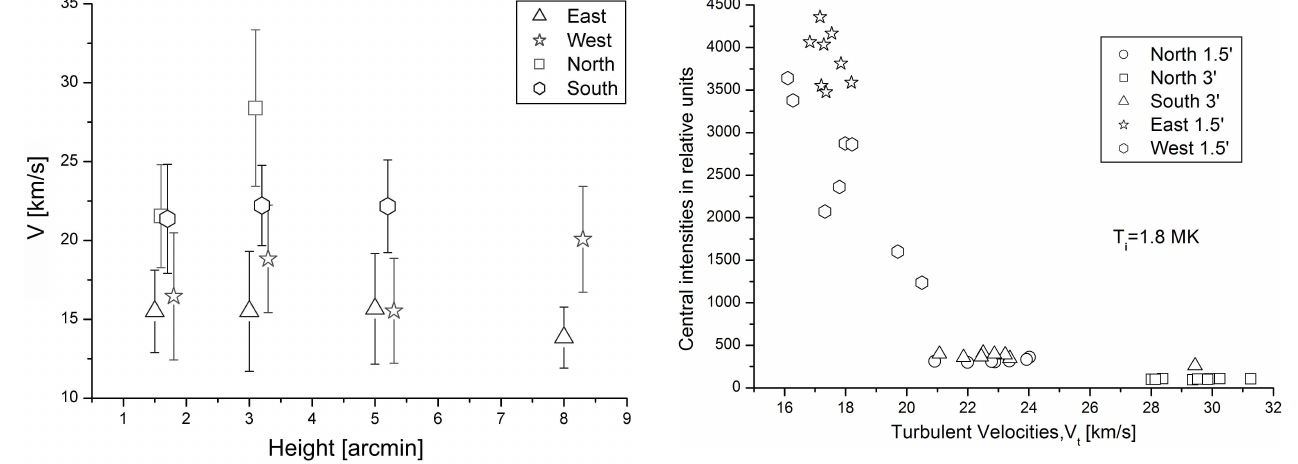
Fig. 9. Correlation plot between central intensities of each average Fe XIV line profile and the corresponding turbulent velocities. It shows different velocities V t , depending on the distance from the limb (for polar regions only) and, in particular, on the latitudes of the emission and the